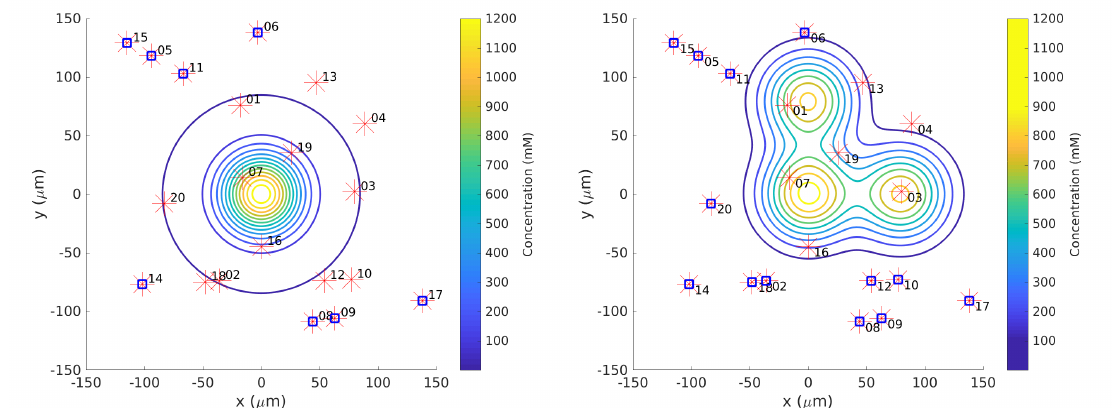
Figure 2. Twenty initial positions for all simulation trials marked as red asterisks. Some trials began in detectable concentration ( C > 1m M —the outer blue circle) and some began outside. Positions marked with blue squares on top of the asterisks fell outside the region covered by the grayscale poster. Therefore, the remaining positions were used for all experimental